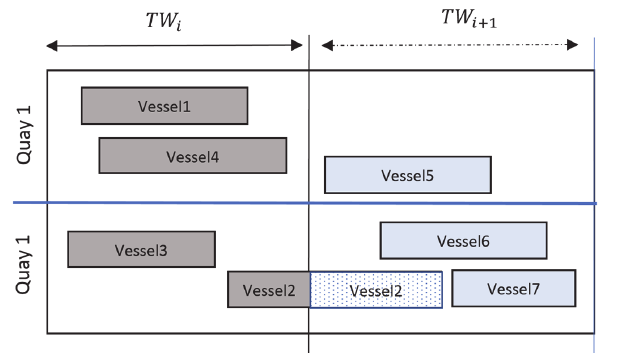
Fig. 1. Vessels overlapping over consecutive time